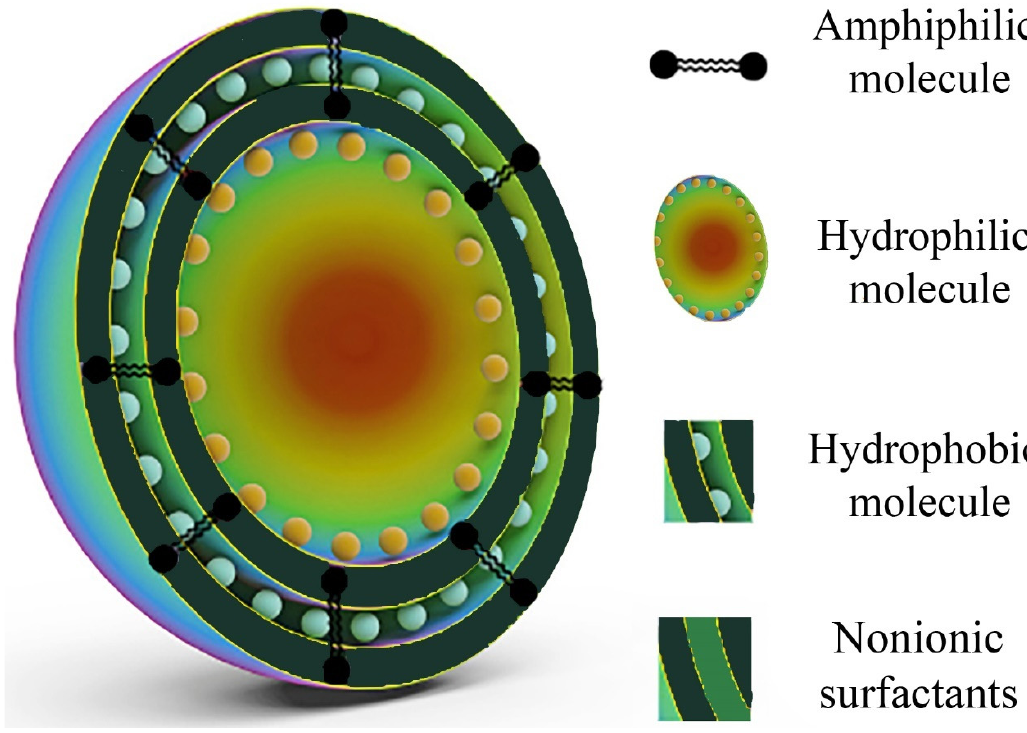
Figure 2. General structure of niosomes .